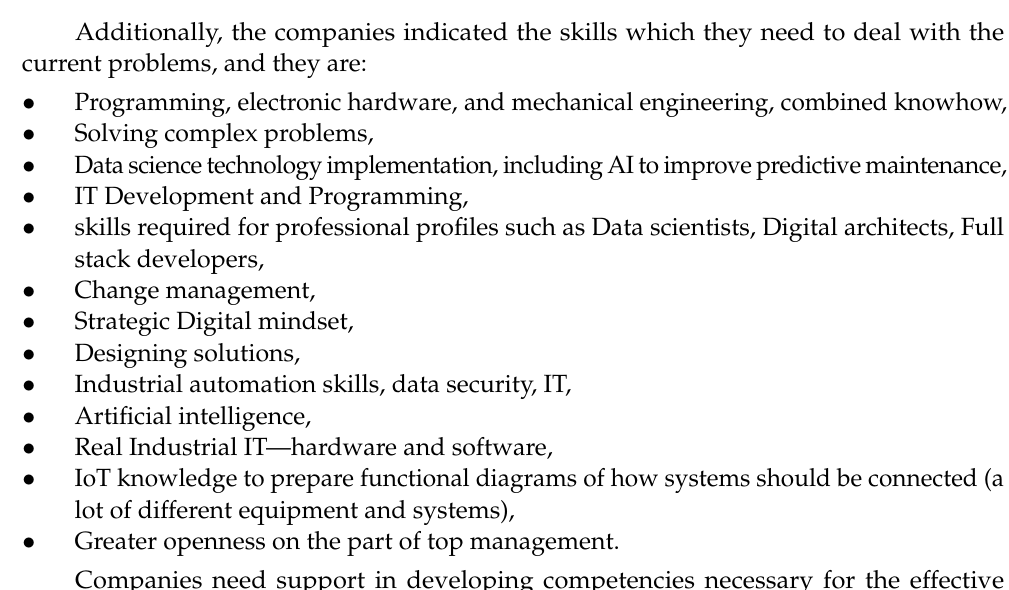
Figure 22. Practical skills level of the presented technologies (weighted average) in the range from 1 (not at all) to 6 (to a very great extent).